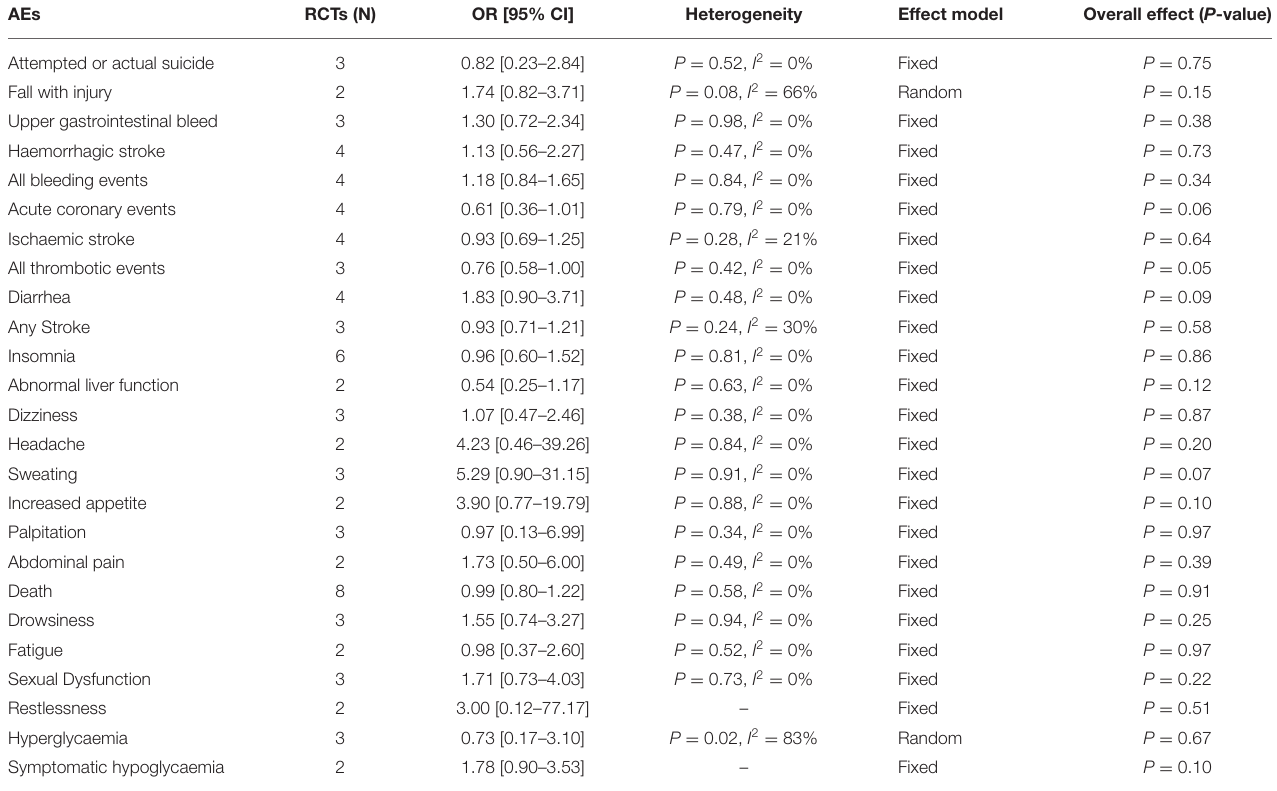
TABLE 2 | Meta-analyses of AEs not related to SSRIs reported in the included RCTs. AEs RCTs